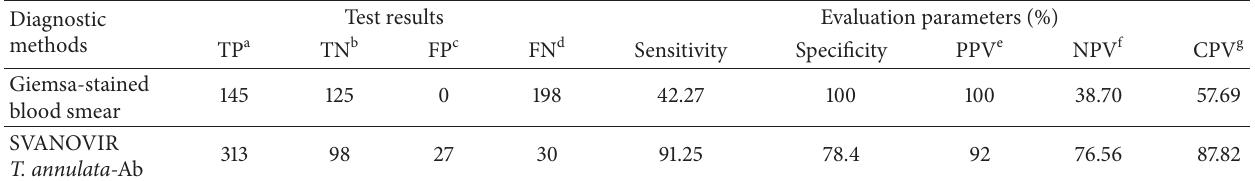
Table 3: Evaluation of conventional and SVANOVIR T. annulata- Ab for diagnosis of Theileria annulata in cattle. Cut-off 46 PP. Diagnostic